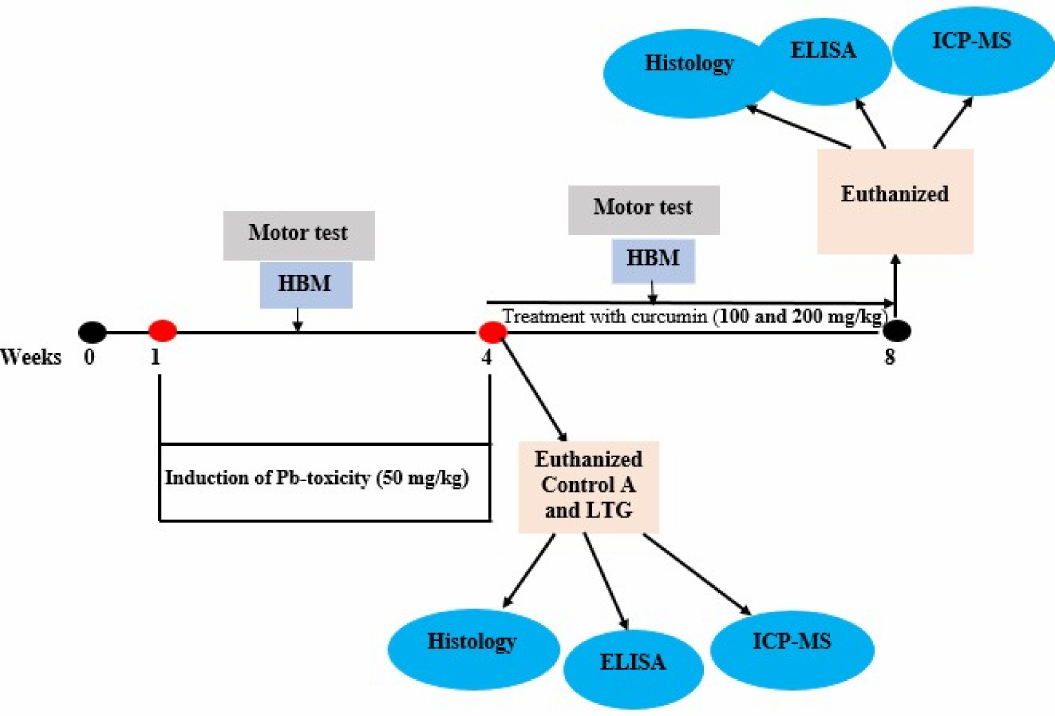
Figure 1. Schematic representation of the experimental design. HBM: Horizontal bar method; LTG: Lead-treated group; ICP-MS: Inductive coupled plasma spectrometry.